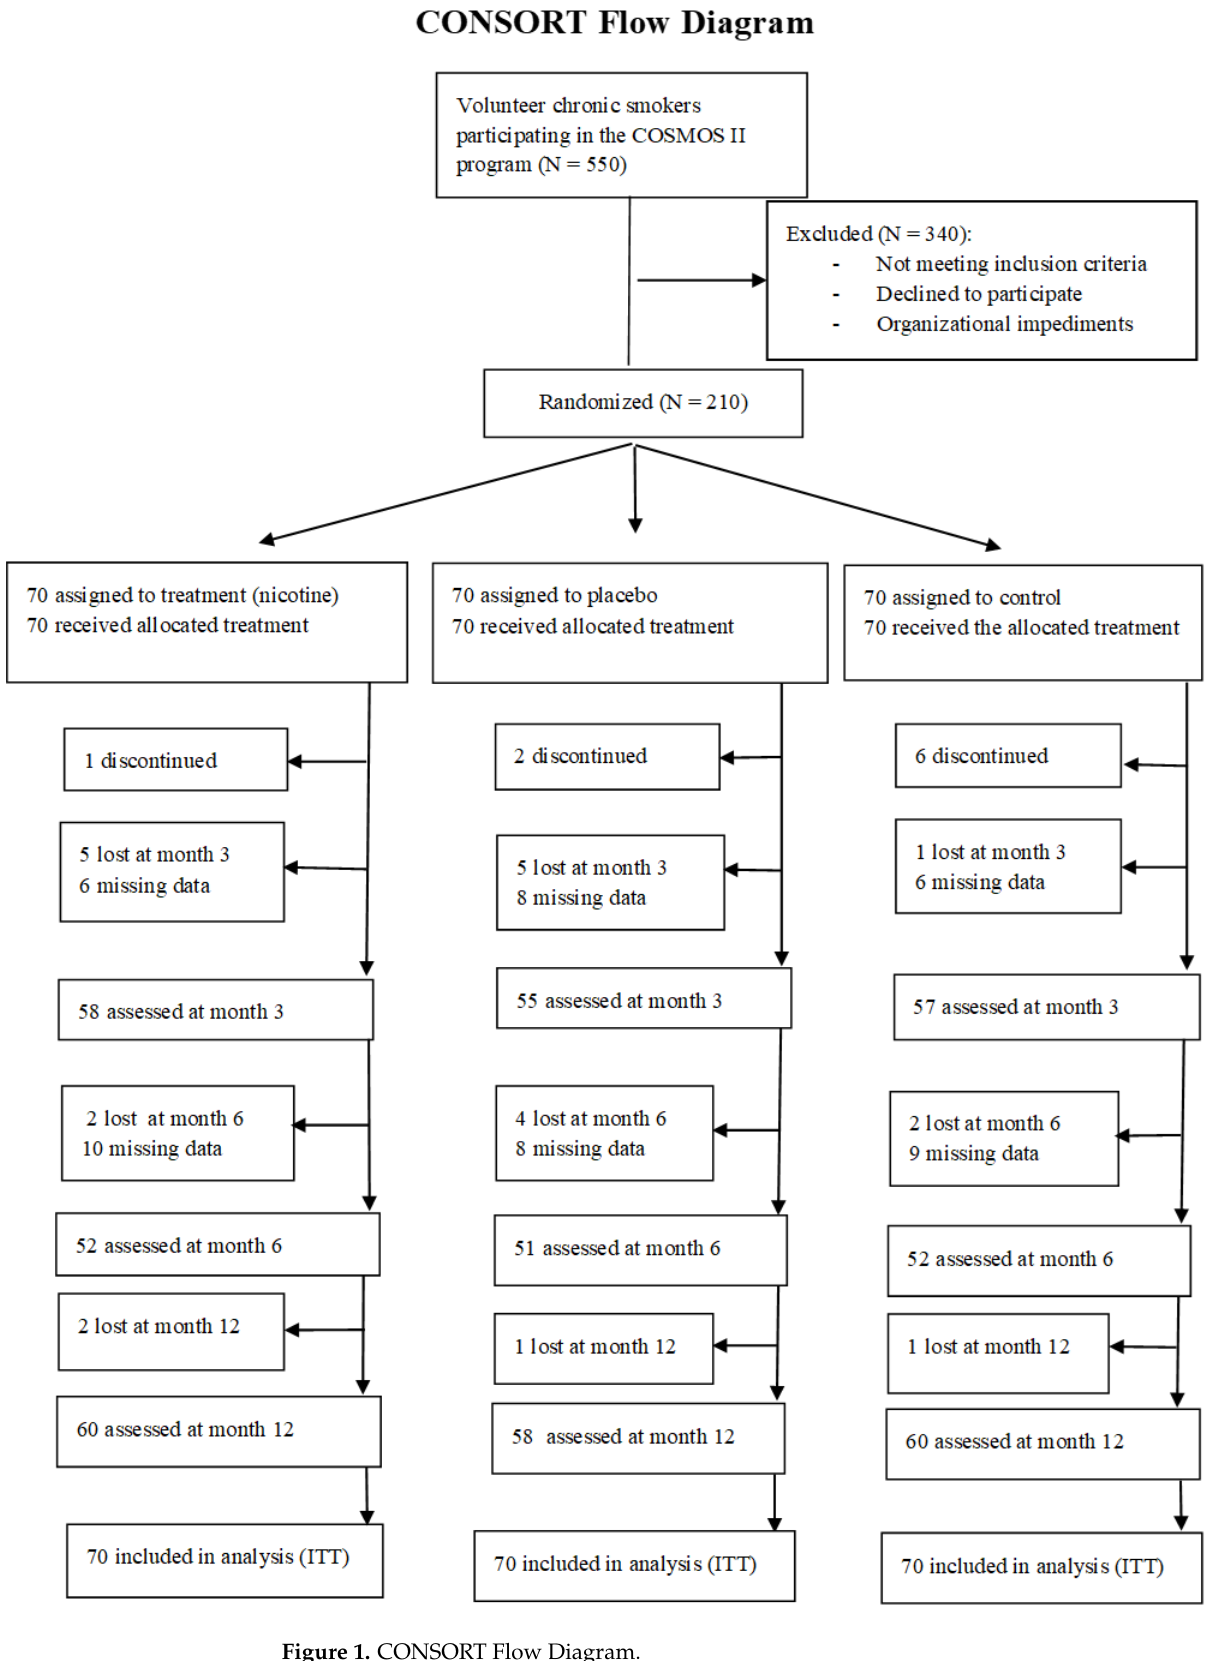
Figure 1. CONSORT Flow Diagram.